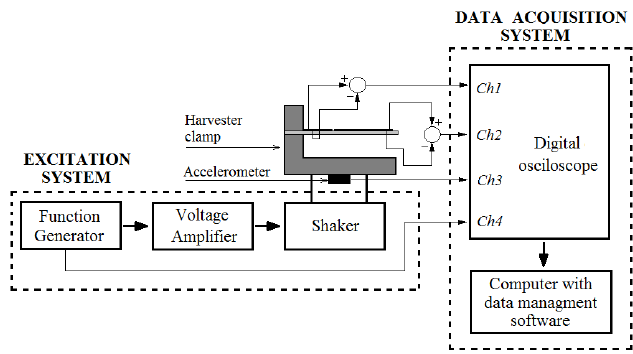
Figure 12. Scheme of the experimental setup.